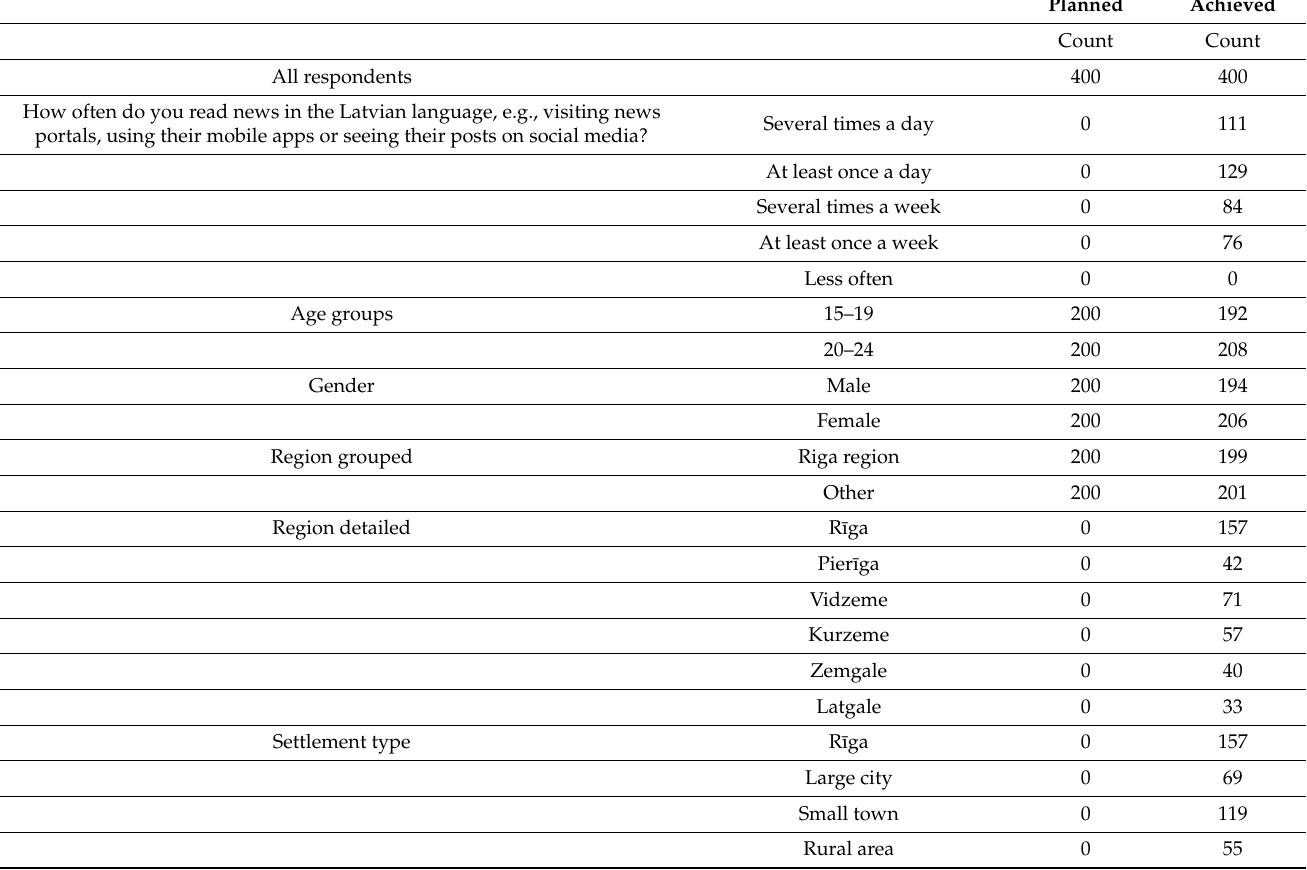
Table 1. The sample size distribution. Latvia, May